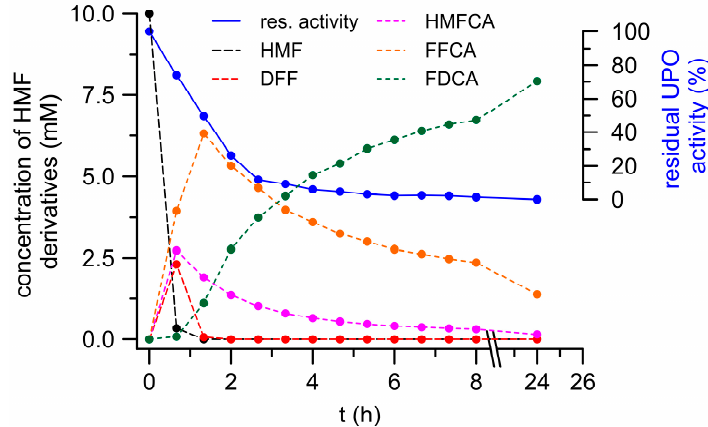
Figure 4. FDCA formation in a cascade-reaction of three oxidoreductases (GAO, Pery AAO, and Aae